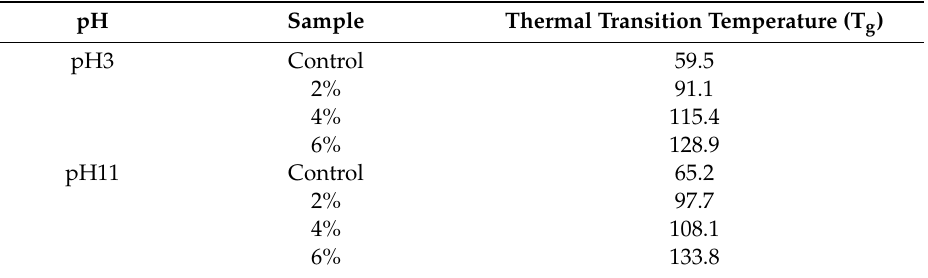
Table 3. Thermal transition temperature of surimi-based edible films incorporated with green tea extract. pH Sample Thermal Transition Temperature (T g ) pH3 Control